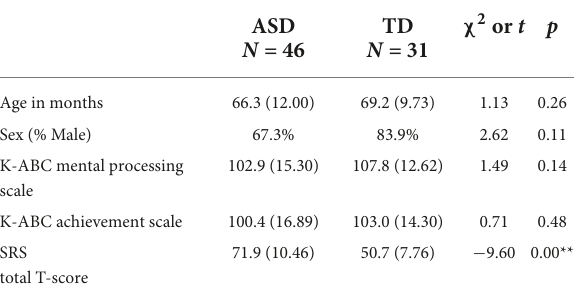
TABLE 1 Participants’ characteristics.